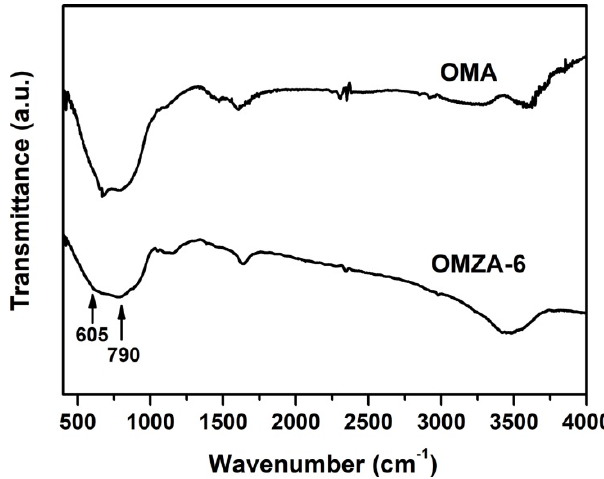
Figure 6. FT-IR spectra of samples OMZA-6 and OMA.